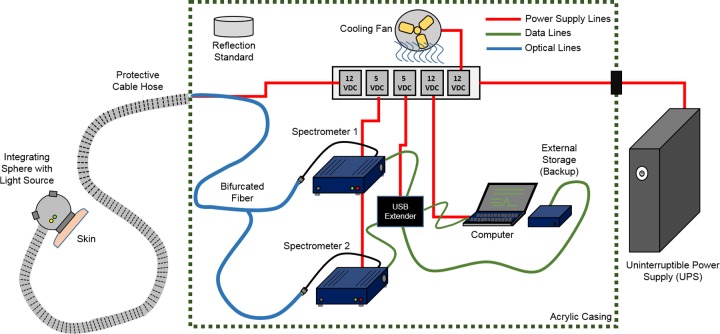
Spectroscopy setup.